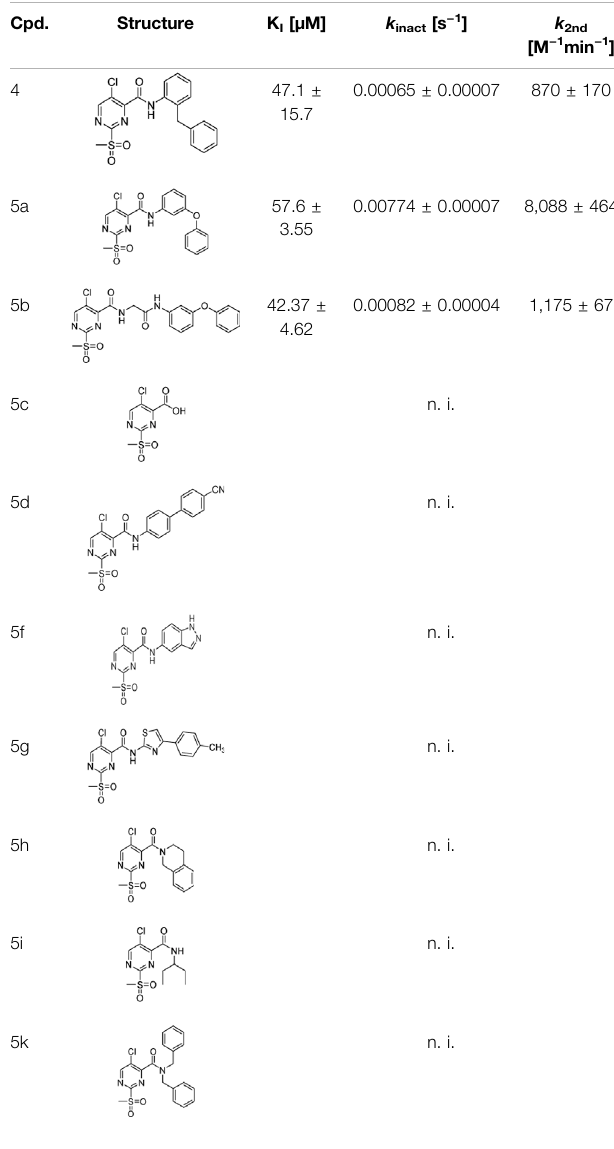
TABLE1| Inhibitionconstants(K I , k inact , k 2nd )ofthecompounds 4 and 5a – k for S. aureus SrtA; n. i. (cid:1) < 20% inhibition at 100 µM.